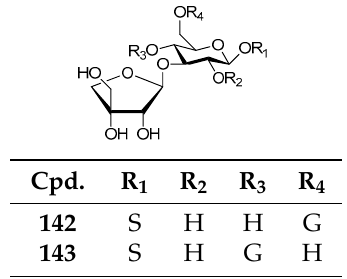
Figure 9. Structure of compound 141 .